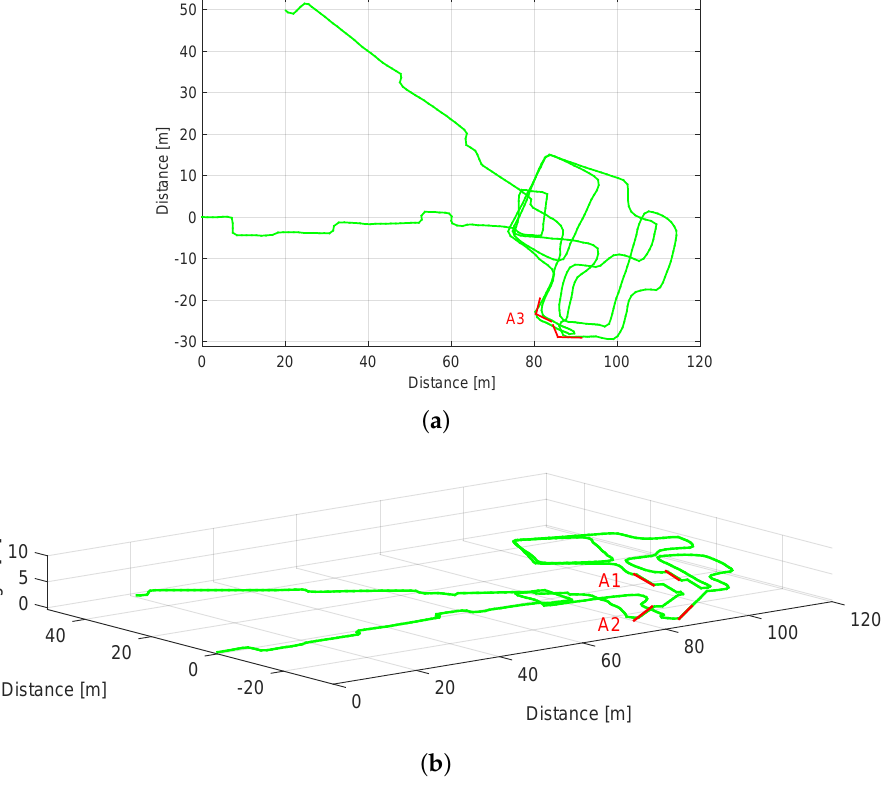
Figure 14. 2D and 3D view of the walk recorded at the Deutsches Museum without compensating the drift. The associations are highlighted in the figure: ( a ) includes in red the corner situated on the ground floor and ( b ) includes in red the associations of the staircase.